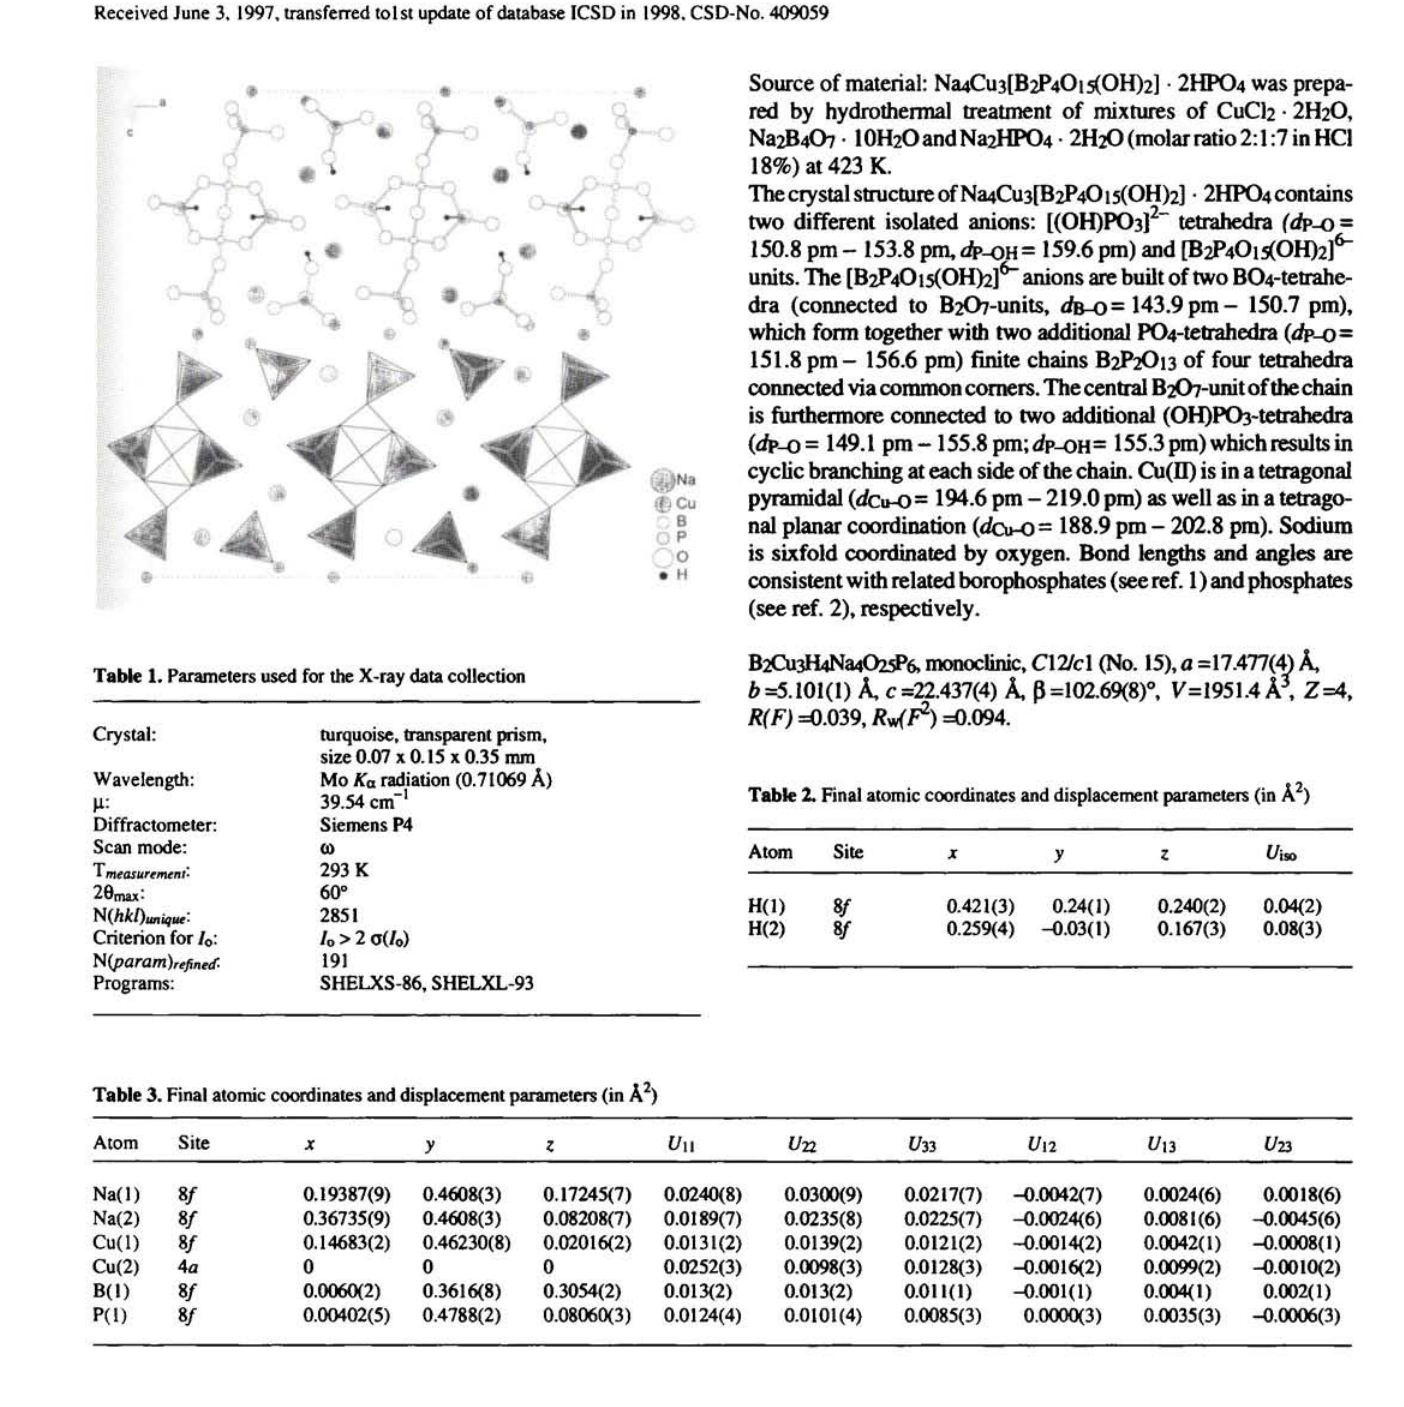
Table 2. Final atomic coordinates and displacement parameters (in λ^)